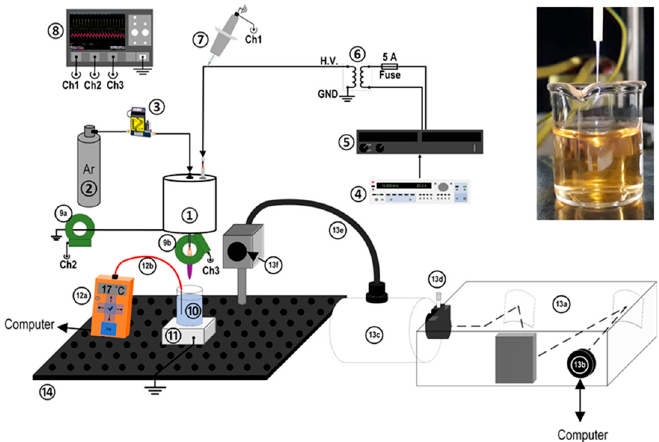
Figure 1. Main components of the experimental setup. 1: plasma jet reactor; 2: carrier gas reservoir; 3: mass flow controller; 4: signal generator; 5: power amplifier; 6: step-up transformer; 7: high voltage divider; 8: oscilloscope; 9: current transformer; 10: specimen; 11: specimen holder; 12a: optical thermometer circuitry; 12b: optical fiber; 13a: spectrometer; 13b: CCD camera; 13c: optical matcher; 13d: micro-slit; 13e: optical fiber; 13f: optical probe; 14: optical breadboard. The top-right inset illustrates the plasma-DDW interaction. Swirling-induced agitation is distinguishable, whereas the yellowish color is due to the reaction between HE and O •− , which forms 2-OH-E + 2